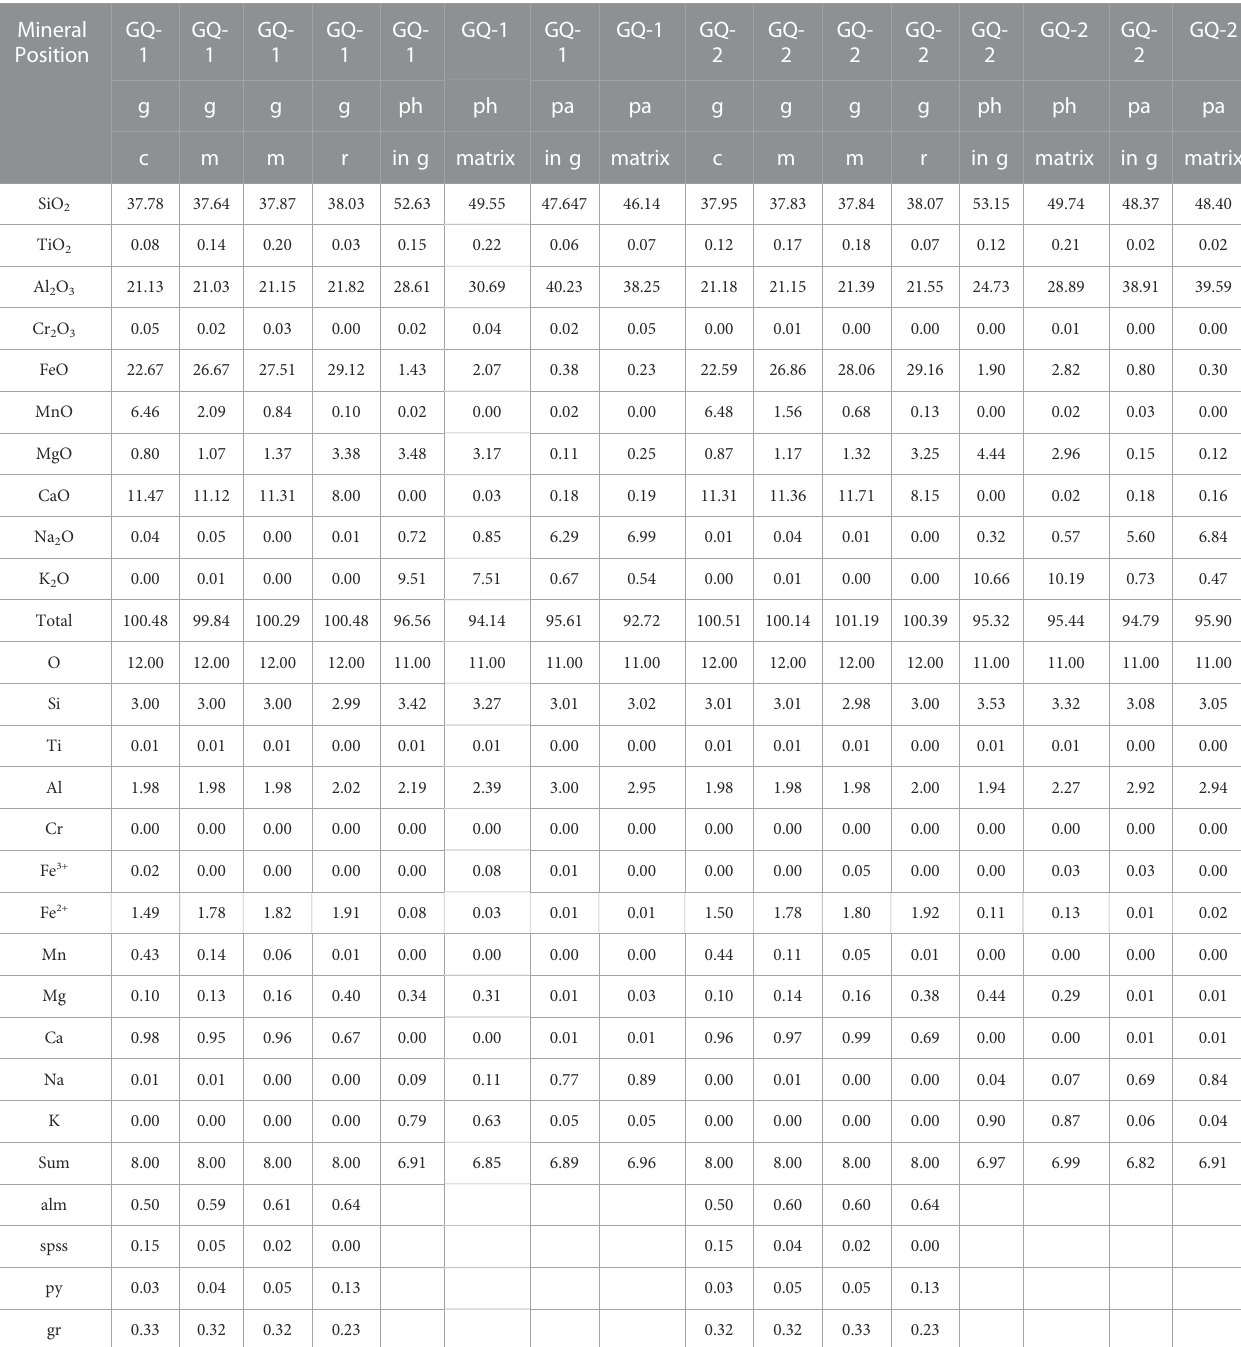
TABLE 1 Representative compositions of garnet, paragonite and phengite from eclogite at Gaoqiao, western Dabie. Mineral